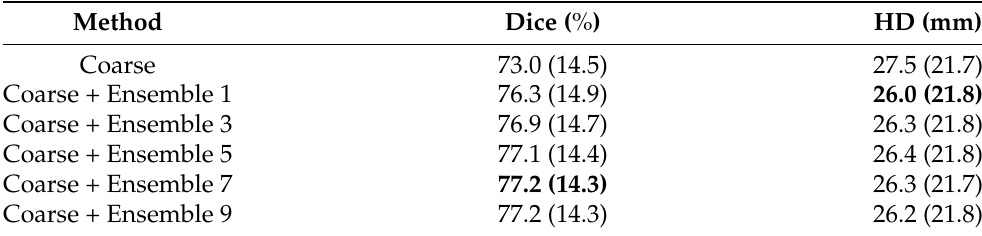
Table 3. Mean (standard-deviation) segmentation performance obtained for the coarse segmentation followed by different ensemble sizes.